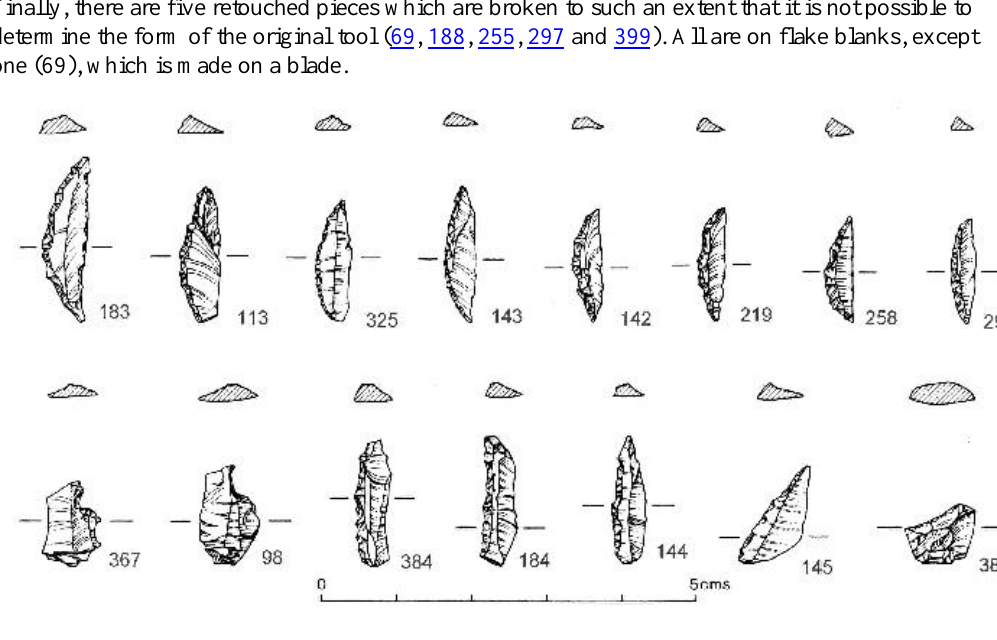
Figure 8: The lithic assemblage: microliths, 183, 113, 325, 143, 142, 219, 258 & 296 crescents; 367 & 98 microburins; 384 & 184 backed bladelets; 144 fine point; 145 & 381 obliquely